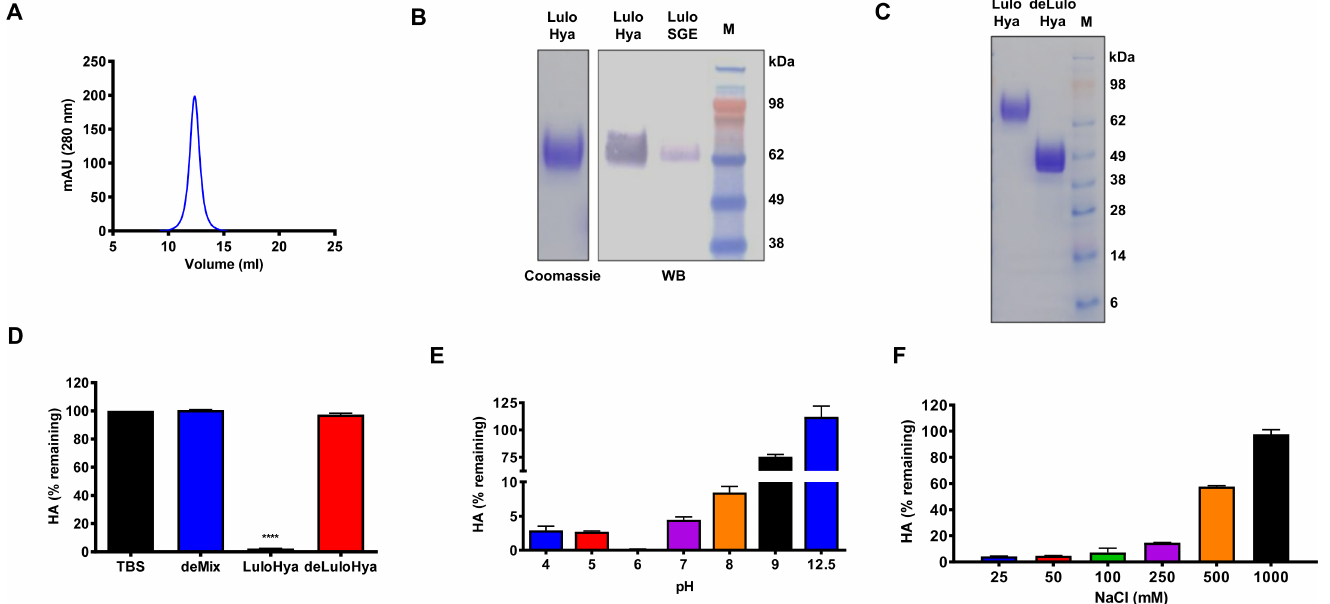
Fig 3. Biochemical characterization of the recombinant protein LuloHya. (A) Purification of LuloHya by size exclusion chromatography using Superdex 200 Increase 10/300 GL column. (B) Coomassie-stained gel electrophoresis of LuloHya (1 μ g). Mouse anti-LuloHya antibodies (1:5,000) recognized LuloHya (100 ng) and a single band in the SGE (5 pairs of SG) by Western blot. M: SeeBlue Plus2 Pre-Stained Protein Standard (Life Technologies). (C) NuPAGE Novex 4–12% Bis-Tris protein gel shows differences in electrophoretic pattern of LuloHya (1 μ g) and its deglycosylated form (deLuloHya: 1 μ g) which runs at the expected molecular weight (42.3 kDa). M: SeeBlue Plus2 Pre-Stained Protein Standard (Life Technologies). (D) Hyaluronidase activity of 10 nM LuloHya and its deglycosylated form (deLuloHya). As negative controls, 4 micrograms of HA were incubated with TBS instead of recombinant protein or the deglycosylation enzyme mix (DeglycoMx Kit, QABio) without protein. (E) Turbidimetric assay showed a clear pH dependence of hyaluronidase activity of LuloHya. Reaction mixtures were prepared with solutions containing 25 mM buffer (described in Methods), 100 mM NaCl, 0.1% BSA, and different pH values (4–12.5; adjusted with a pHmeter 430, Corning). (F) Ionic strength dependency was analyzed in reaction mixtures of 25 mM HEPES, 0.1% BSA, pH 7.3 with variable NaCl concentration (25–1000 mM). Hyaluronidase activity is inversely expressed as the remaining HA (%) after treatment of 4 μ g of HA with 10 nM enzyme during 1 h at 37˚C. Biological triplicates and technical duplicates were assessed. Multiple comparisons were done by one-way ANOVA ( (cid:3)(cid:3)(cid:3)(cid:3) : p < 0.0001). Bars indicate SEM.